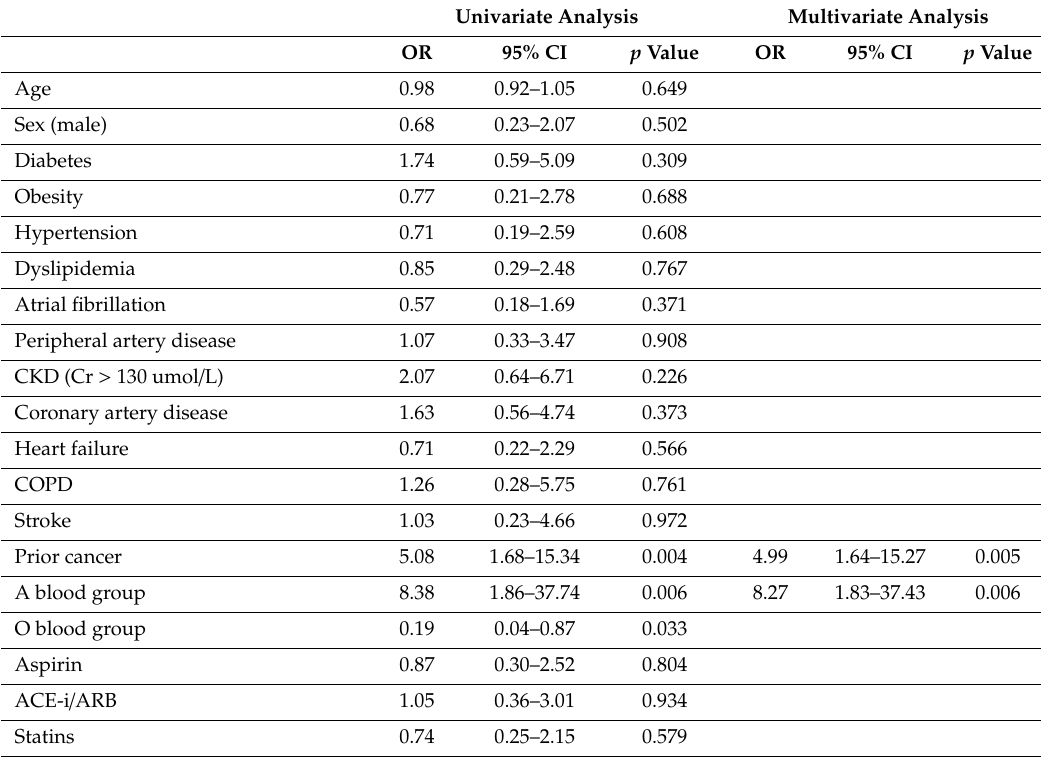
Table 4. Factors associated with severe COVID-19 in patients who had undergone transcatheter aortic valve